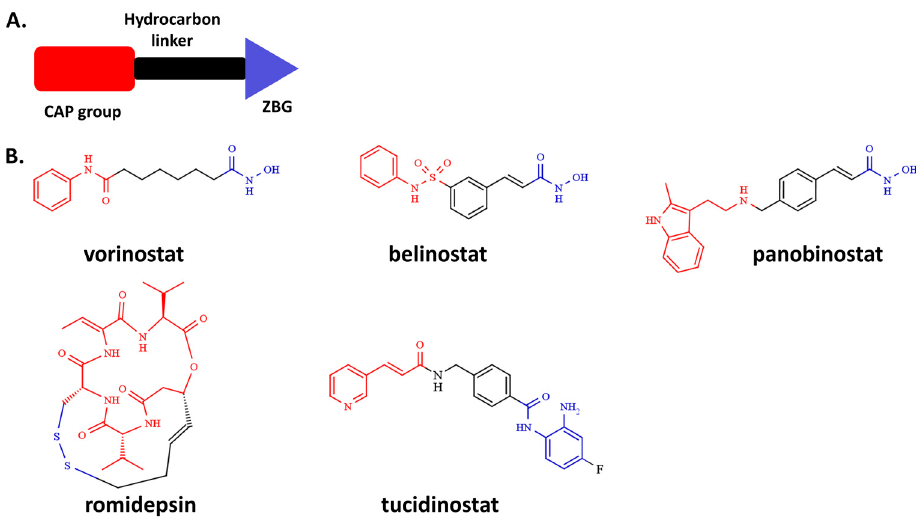
Figure 1. The general pharmacophore model for HDAC inhibitors ( A ) and chemical structures of five FDA-approved HDAC inhibitors ( B ).